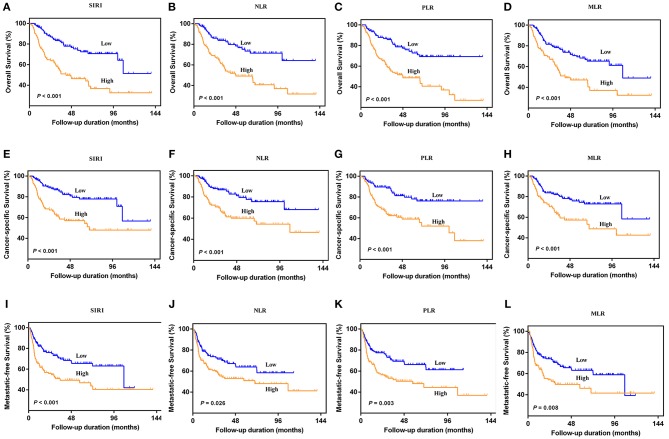
Kaplan-Meier curves for OS (A–D), CSS (E–H), and MFS (I–L) in UTUC patients stratified by SIRI, NLR, PLR, and MLR in the training cohort.